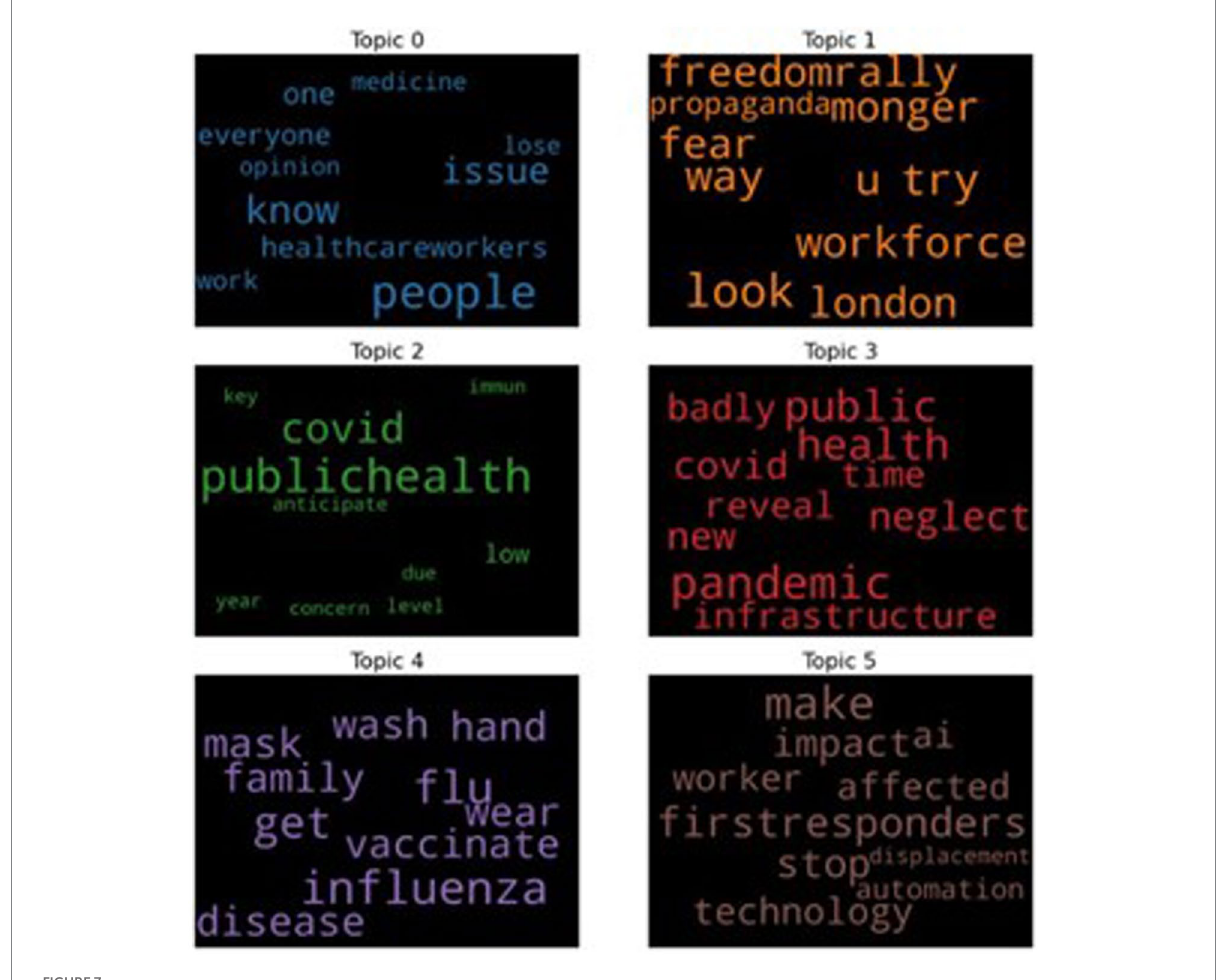
FIGURE 7 The top six topics for the tweets with the negative